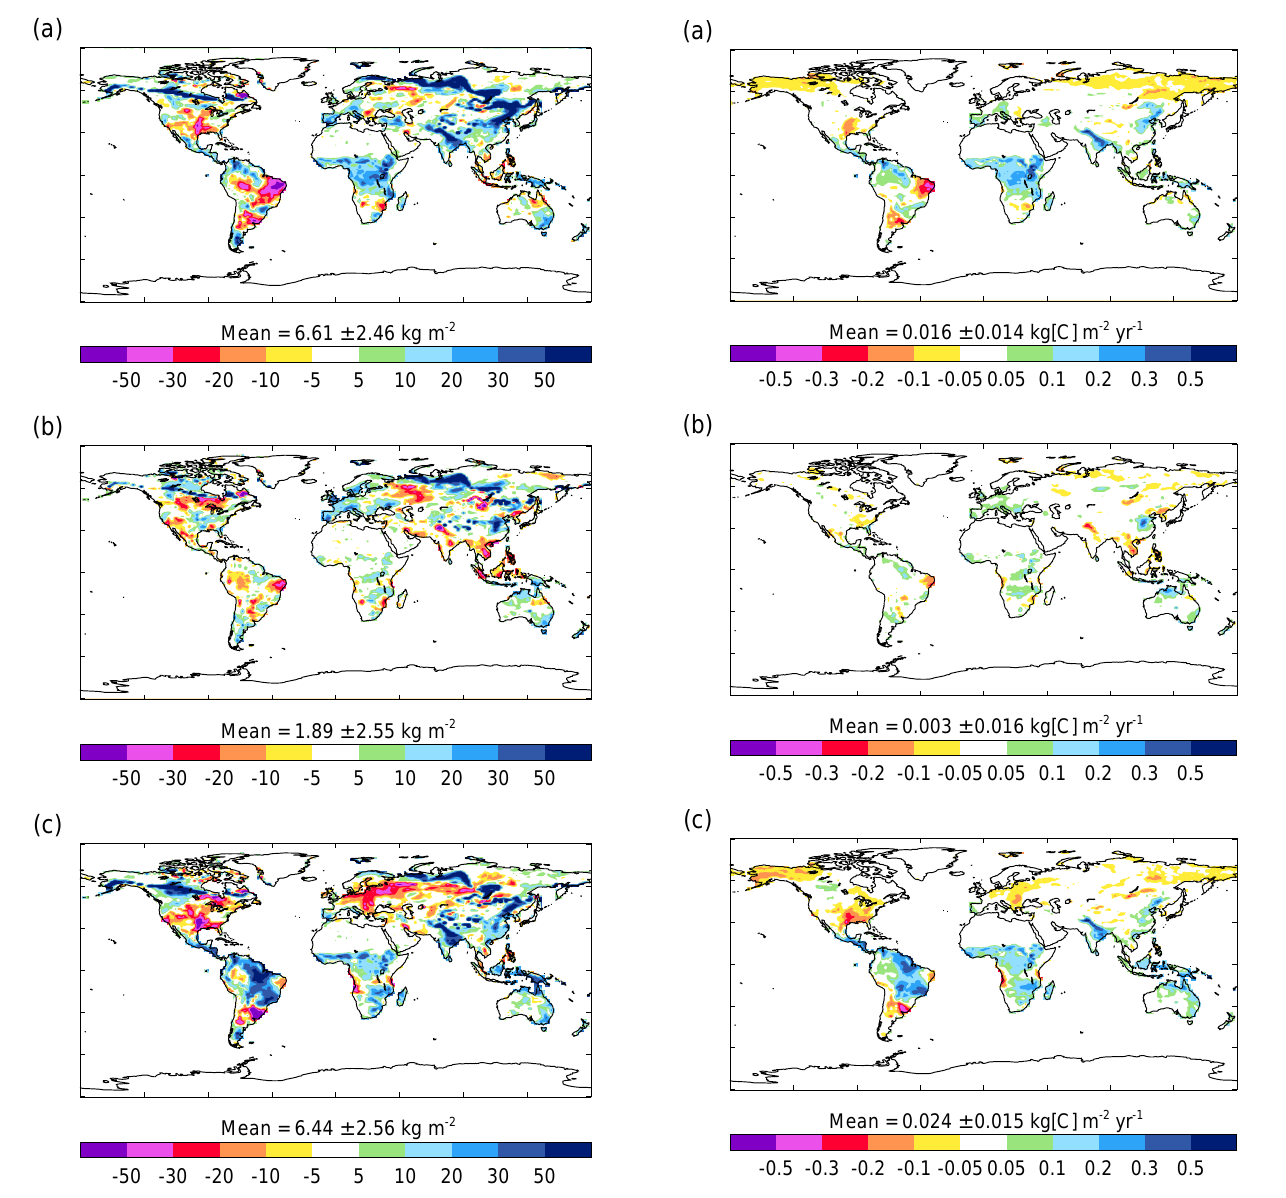
Fig. 8. As Fig. 7 but for mean 2040–2069 changes in vegetation net primary productivity (kg[C] m − 2 yr − 1 ). (a) I-mask; (b) D-mask; (c) I-mask NSA